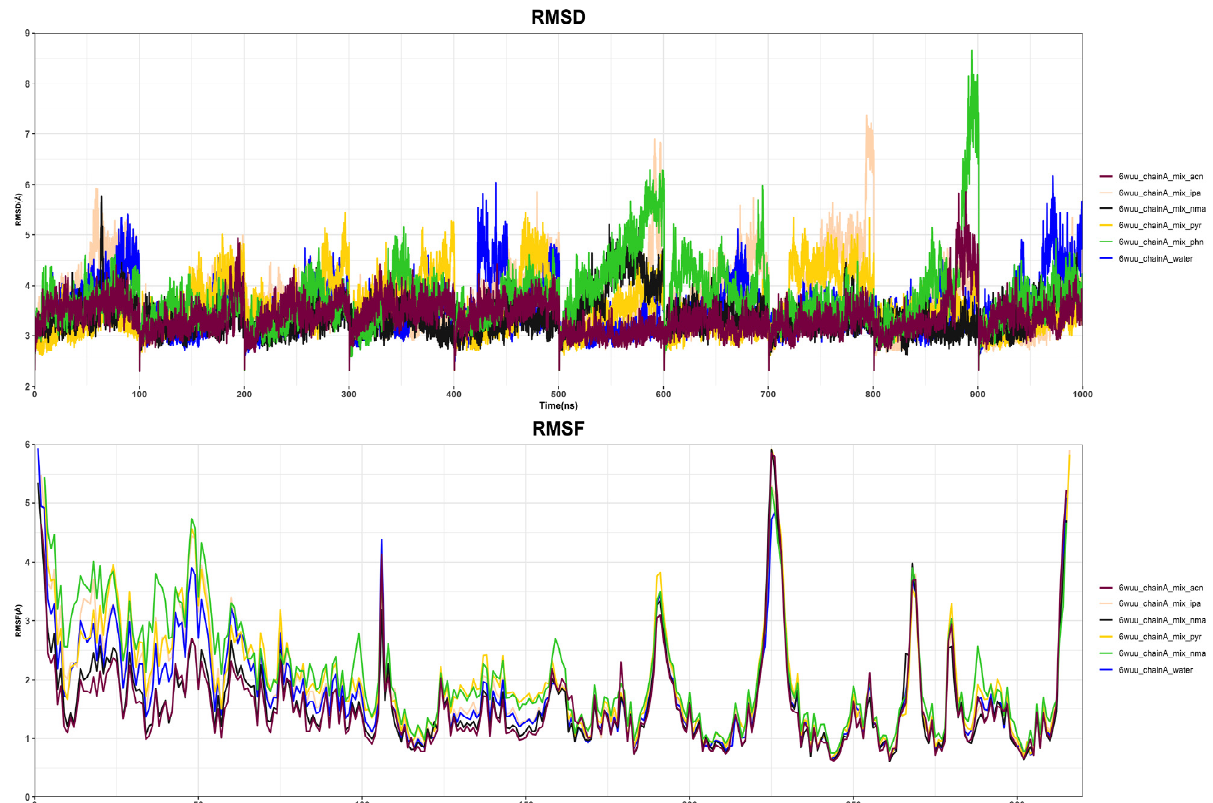
Figure 5. Changes in RMSD and RMSF values in 6 simulation systems.